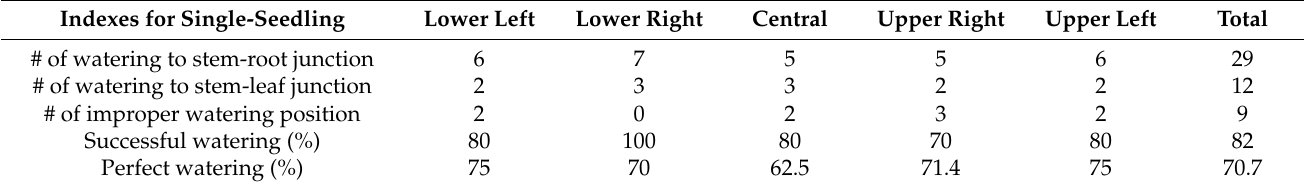
Table 2. Experimental results of automatic irrigation experiments with the same plant but different position of seedling.